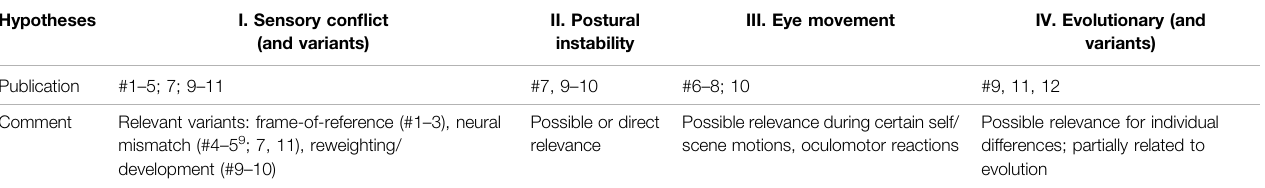
TABLE 1 | Twelve Research Topic Publications (by Number), and their Links to Etiological Hypotheses.